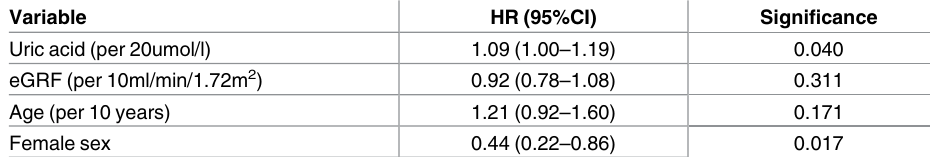
Table 3. Multivariate model.